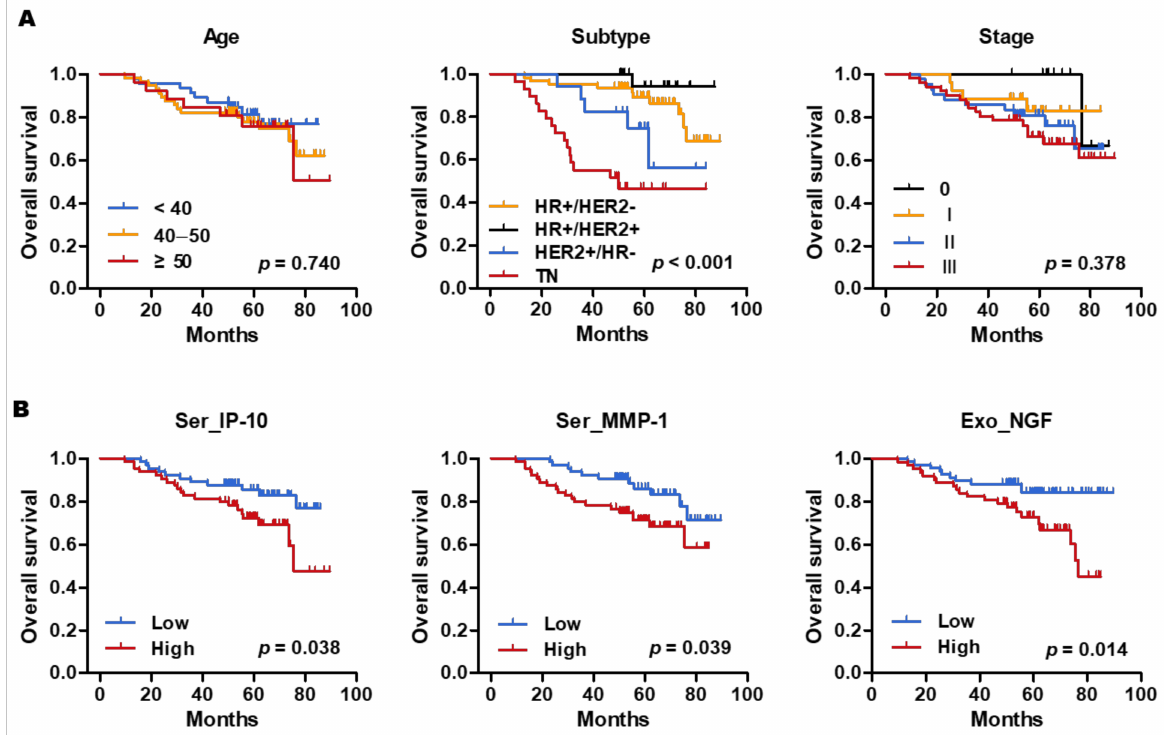
Figure 4. Kaplan–Meier curves for overall survival. ( A ) Kaplan–Meier survival plot for all patients according to age, subtype and stage. ( B ) High levels of Ser_IP-10, Ser_MMP-1, and Exo_NGF were significantly associated with poor